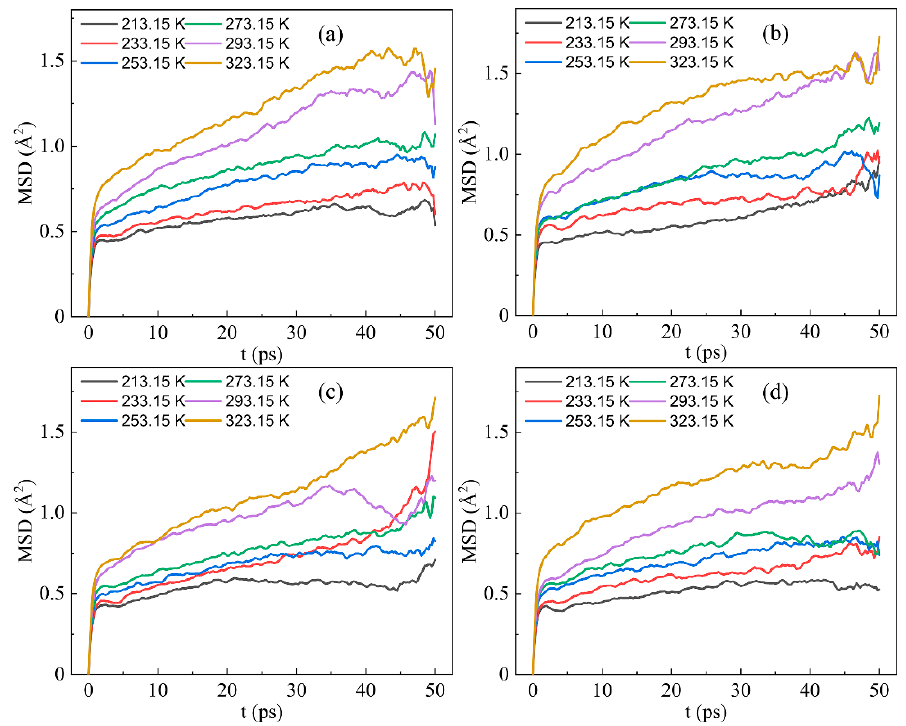
Figure 6. Mean squared displacement of four IPN binder models at 213.15 K, 233.15 K, 253.15 K, 273.15 K, 293.15 K and 323.15 K. ( a ) S-N, ( b ) S-H, ( c ) S-T and ( d ) S-I.